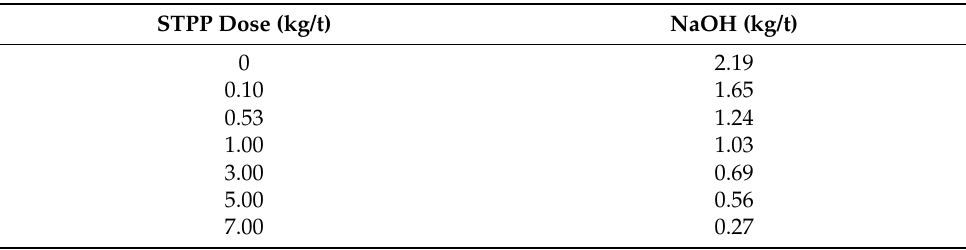
Table 1. Sodium hydroxide required to achieve pH 8 in kaolin pulps 45 wt% according to the sodium tripolyphophate (STPP)